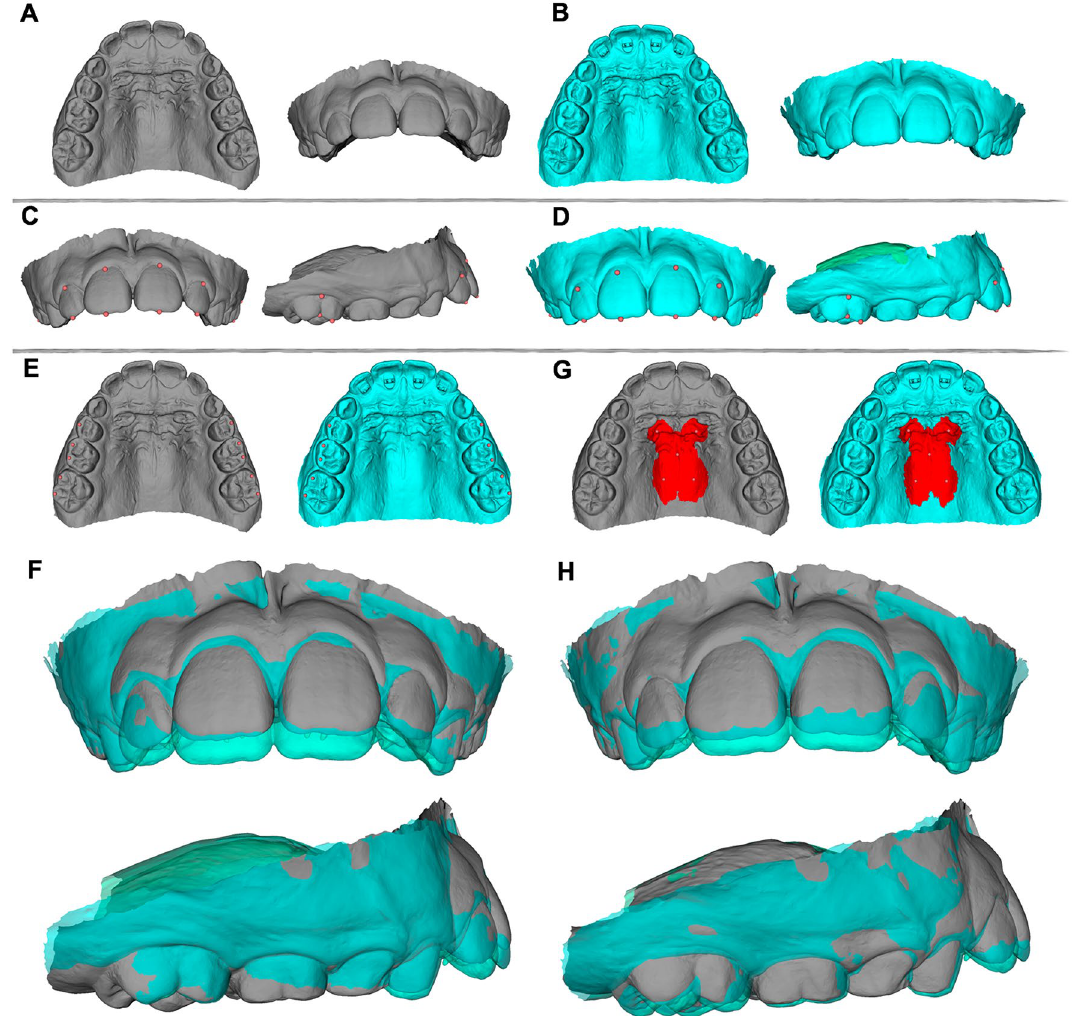
Figure 3. Study’s methodology. ( A,B ) Pretreatment (T1, oriented) and posttreatment (T2 approximated to T1) digital dental models. ( C,D ) Landmarks placed on T1 ( C ) and T2 ( D ) models before registrations and that will be used for quantification of treatment changes. ( E ) Landmark-based registration on the posterior teeth. Landmarks were placed on T1 and T2 models only for registration. ( F ) Registered models after landmarks-based registration on the posterior teeth. ( G ) Registration on the palate using regions of interest. Regions of interest were created on T1 and T2 models for registration. ( H ) Registered models after registration on the palate using regions of